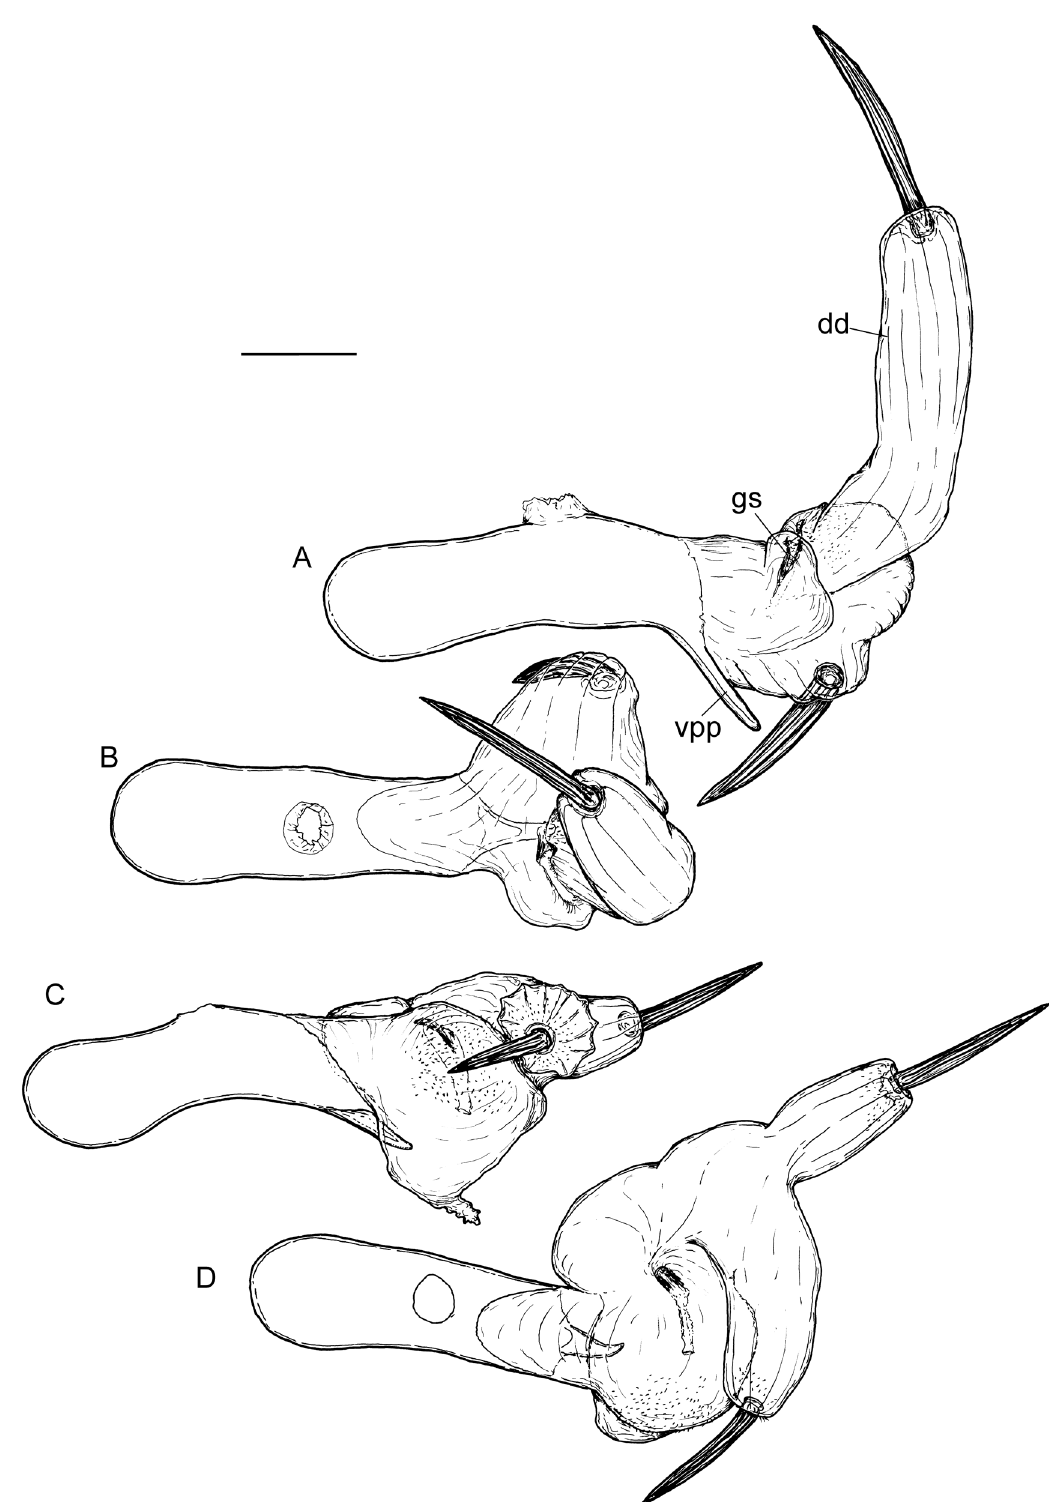
Fig. 7. Phalli with vesica everted of Phtheochroa spp. A–B . P. frigidana (Guenée, 1845) stat. rev., Andorra, Pyrenees, neotype of Eupoecilia frigidana . – C–D . P. cantabriana sp. nov., Spain, Picos de Europa National Park, holotype. A, C: left. B, D: dorsal. Abbreviations as in Figs 5–6. Scale bar = 250